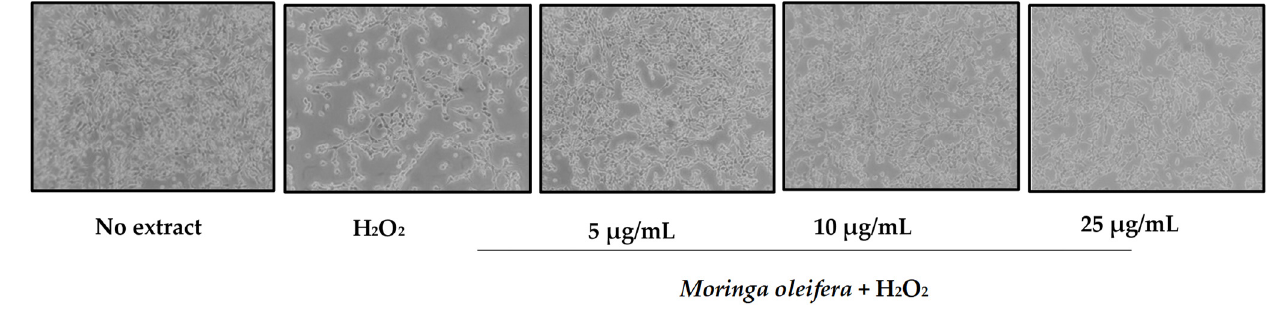
Figure 1. Effect of methanol extracts of Moringa oleifera leaf powder on cell viability and cell morphology. ( A ) Effect of moringa on SH-SY5Y cell viability. Cells were treated with moringa from 5 to 500 µg/ml for 24 h. ( B ) Protective effect of moringa in a hydrogen peroxide-induced oxidative stress model. Cells were pretreated with moringa from 5 to 100 µg/ml for 24 h before 100 µM H 2 O 2 for 1 h. ( C ) Effect of moringa on SH-SY5Y cell morphology. * p < 0.05 versus no extract, # p < 0.05 versus H 2 O 2.